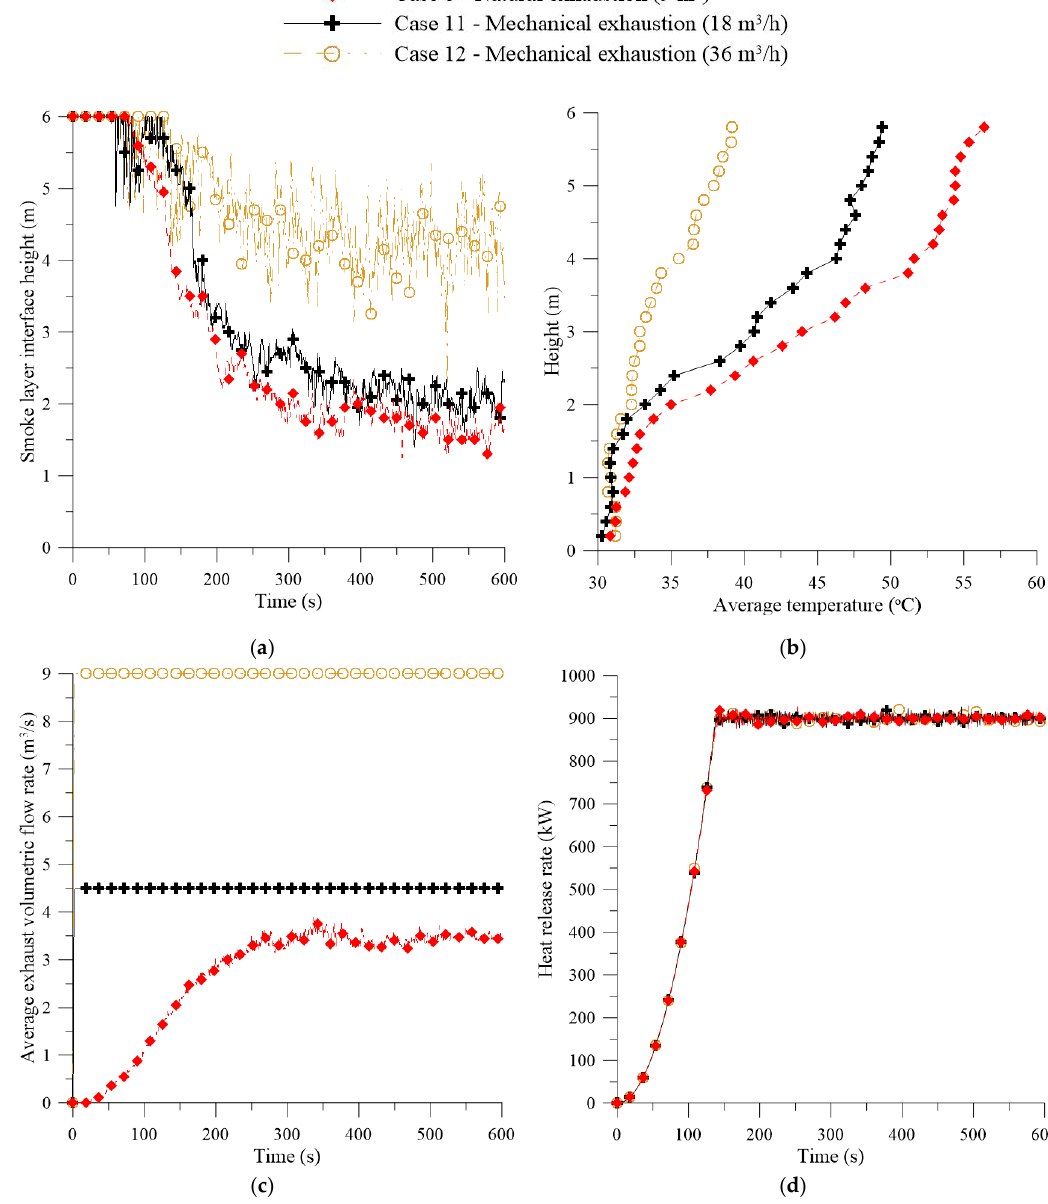
Figure 16. Influence of the mechanical exhaust system in the ( a ) smoke layer vertical displacement; ( b ) average temperature profile at t = 600 s; ( c ) average exhaust volumetric flow rate and ( d ) HRR (compartment with open windows and HRR = 900 kW).